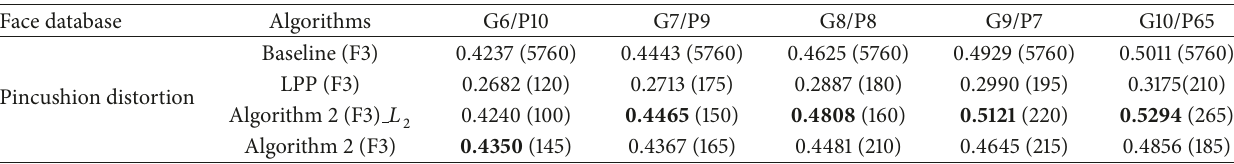
Table 26: The recognition rates on pincushion distortionExtended Yale B face database over “F3” features; recognition rates (dimensionality).